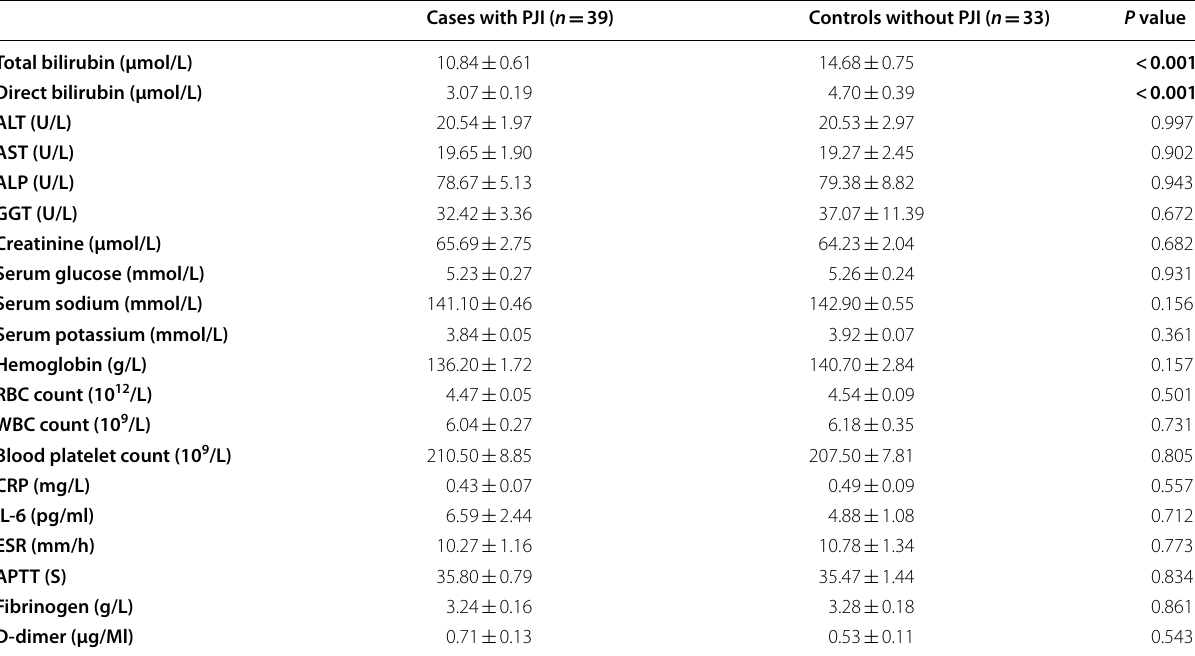
Table 2 Comparisons of preoperative blood biomarkers between cases and controls